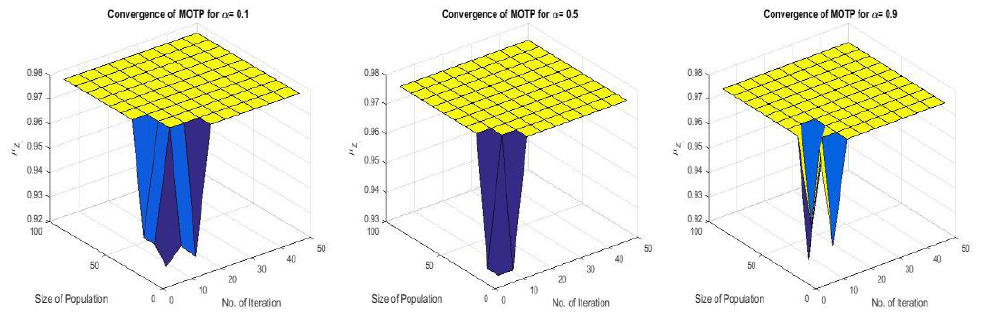
Figure 6. Convergence to the optimum solution for FMOTP at α =0.1, 0.5,